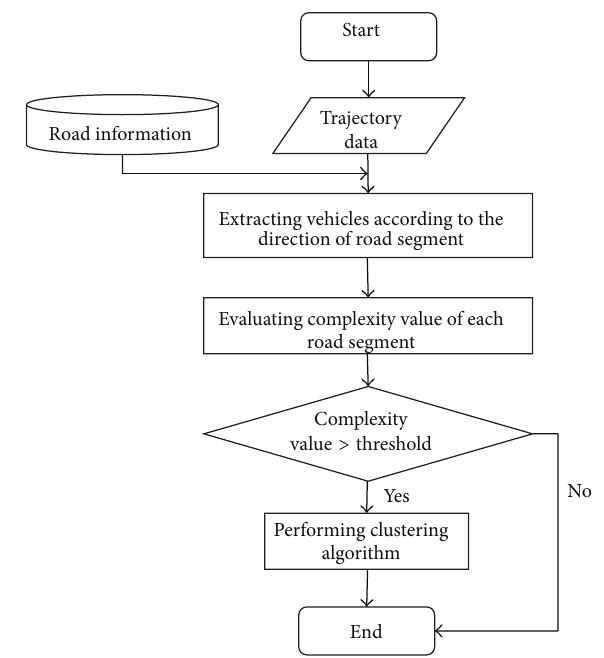
Figure 2: The procedure of computing congested routes.